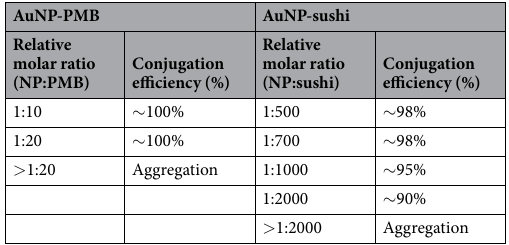
Table 1. Binding efficiencies of PMB and sushi peptides on AuNPs.